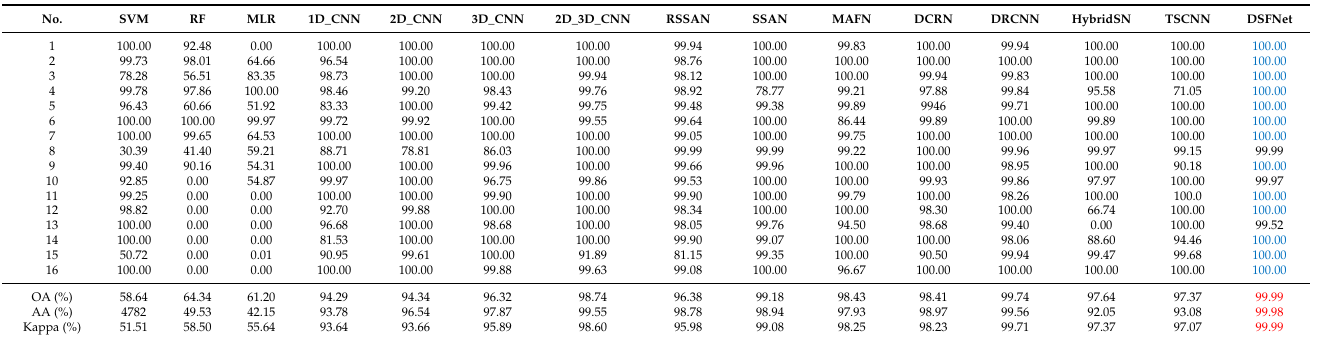
Table 8. Classification results on the SA